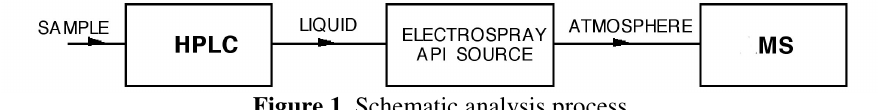
Figure 1 . Schematic analysis process.